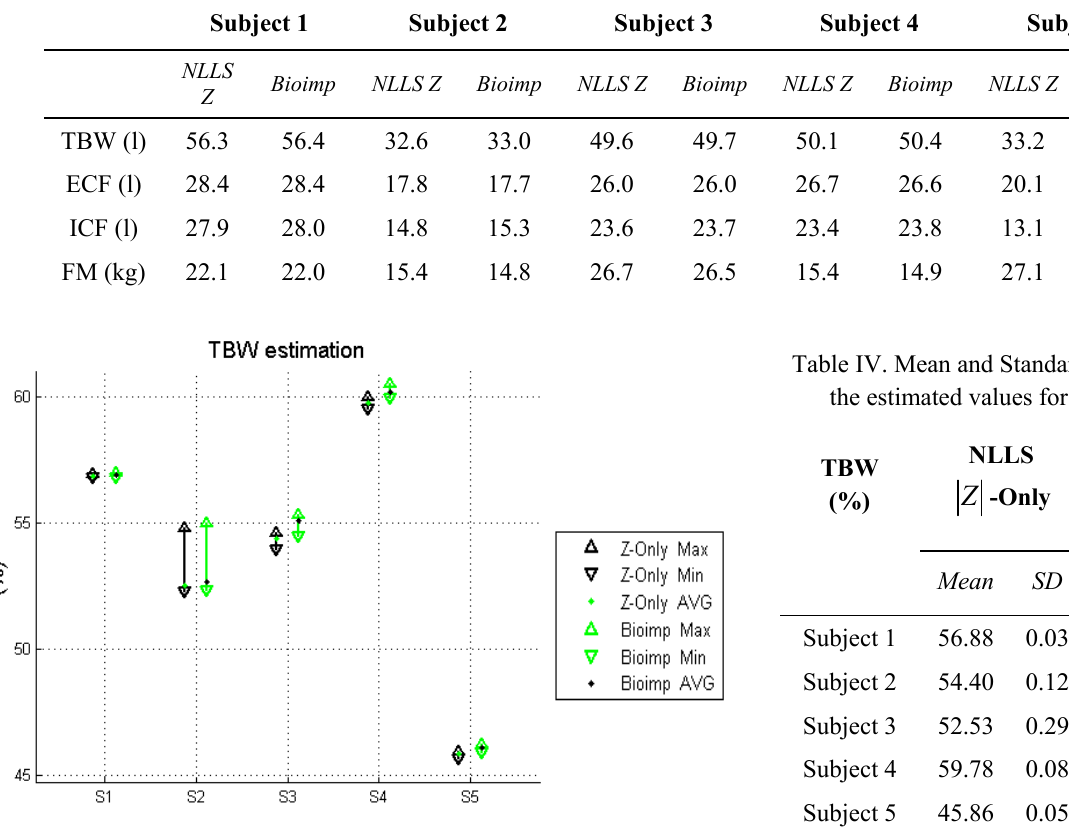
Fig. 2: Mean, minimum and maximum values for TBW, in %, estimated for all the subjects with both methods